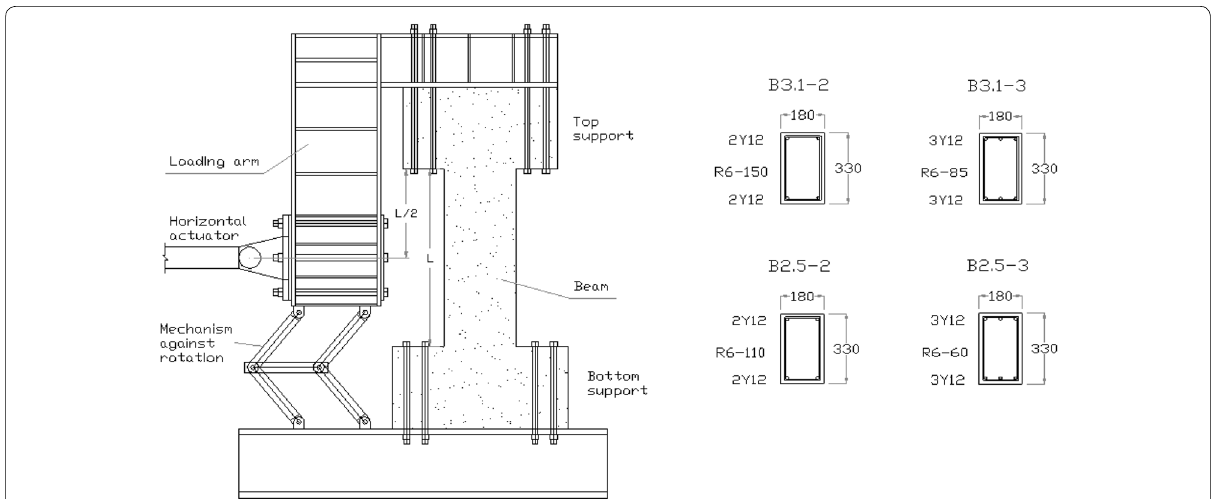
Fig. 1 Experimental setup and beam detailing (Nabilah and Koh 2017).